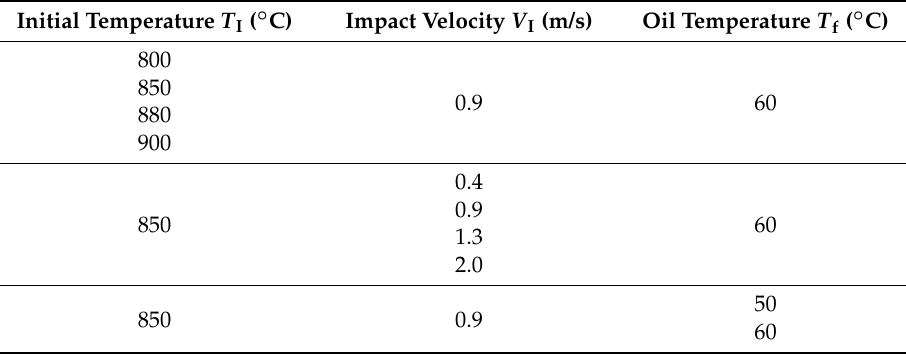
Table 5. Laboratory conditions for oil-quenching